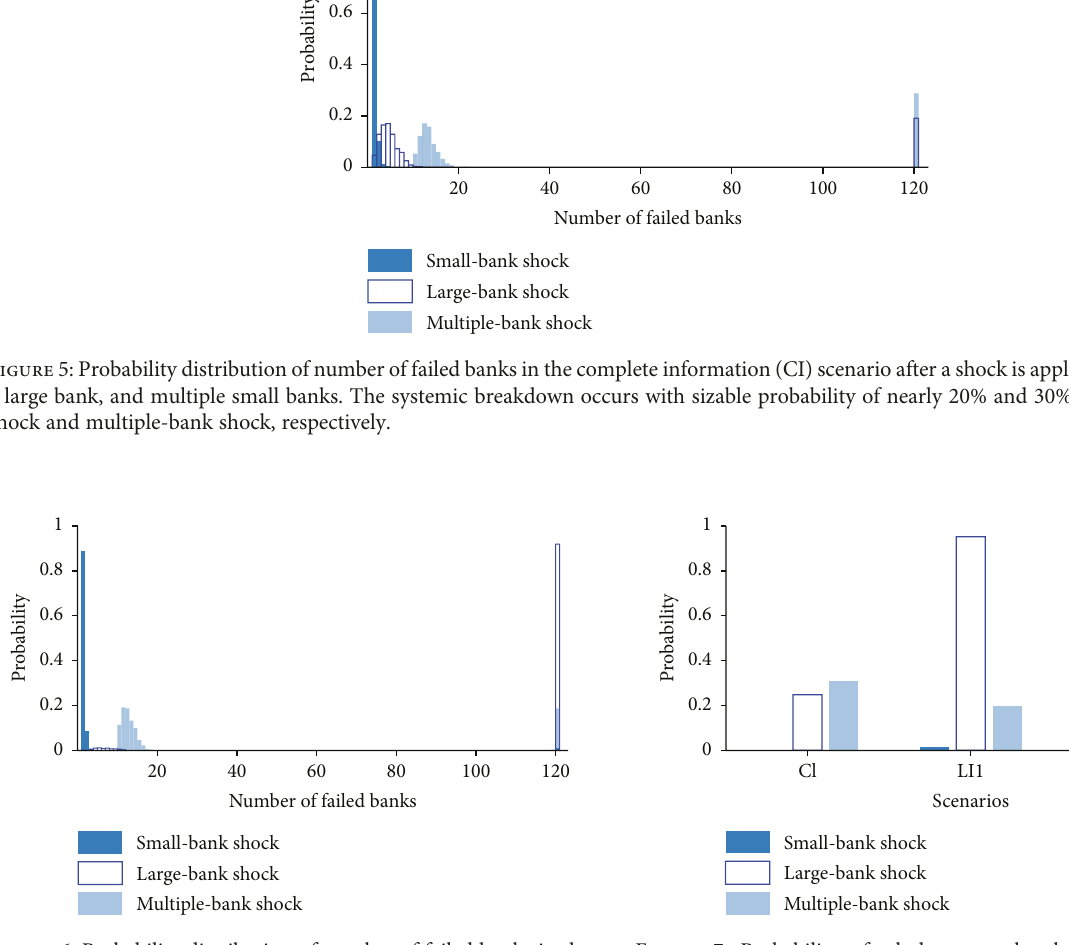
Figure 6: Probability distribution of number of failed banks in the LI1 scenario after a shock is applied to a small bank, a large bank, and multiple small banks. In comparison to the CI scenario, the probability of systemic breakdown increases after both single- bank-shock treatments, whereas it drops after multiple-bank shock. LI1 is a scenario in which a bank has access only to information from its direct neighbors at distance 1. LI =local information; CI=complete information.